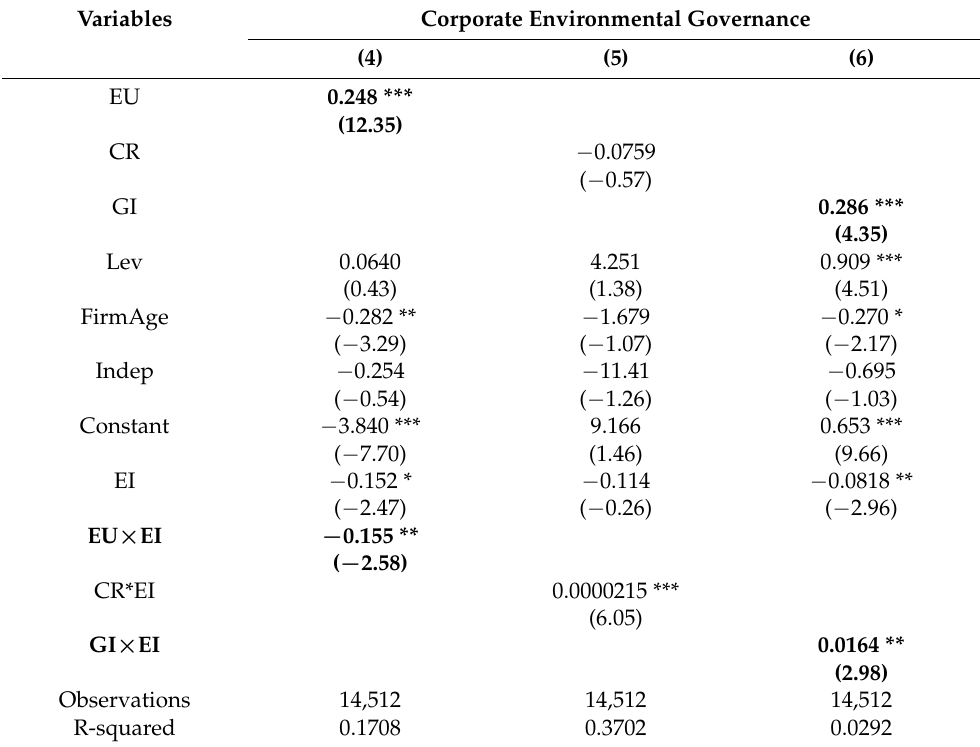
Table 4. The results of moderating